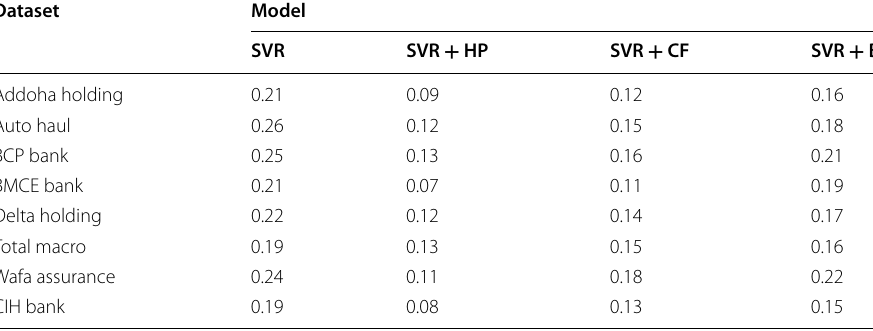
Table 6 MAPE (Error rate) of the predictive models